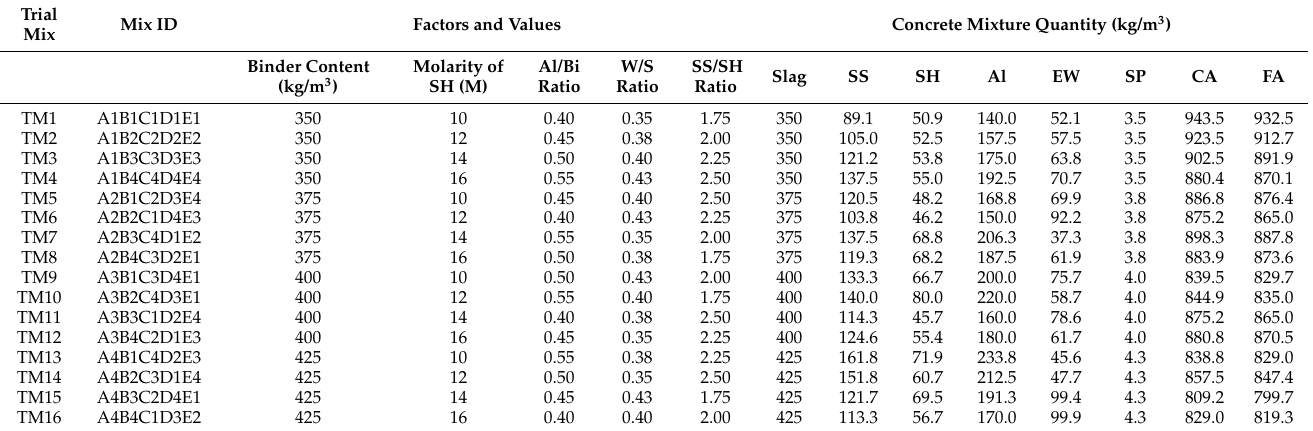
Table 3. Sixteen sets of mixtures of AASC as per L 16 orthogonal array and their mix